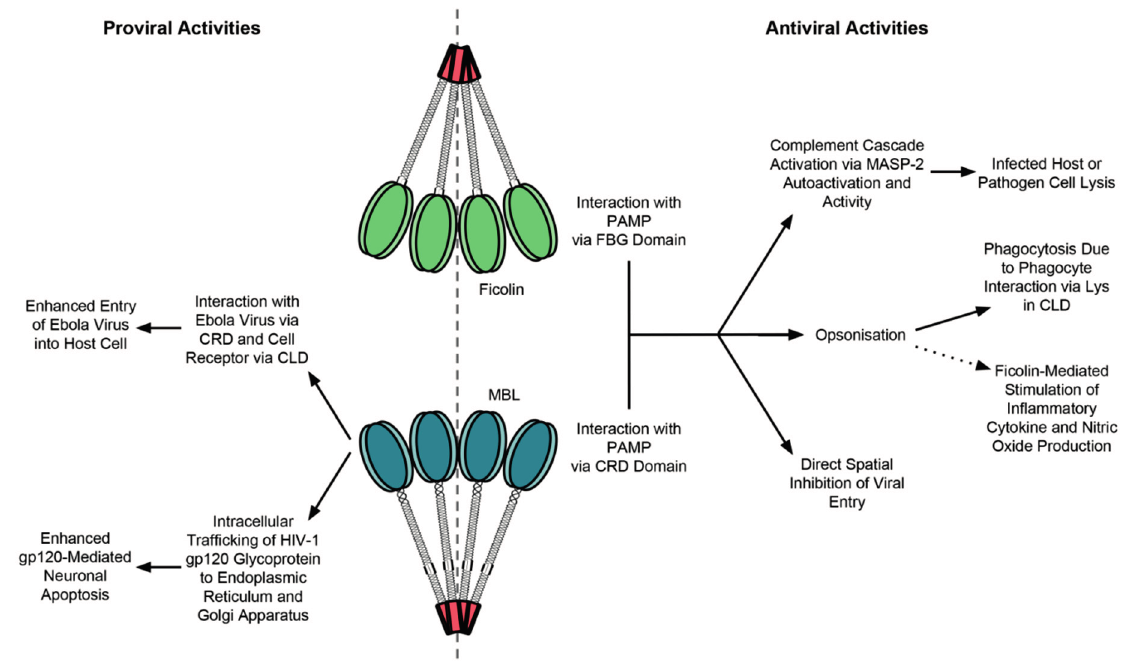
Figure 4. The pro-viral and antiviral activities of serum MBL and ficolins. Both have antiviral activities through complement activation, opsonophagocytosis and direct spatial blocking of virus-receptor interactions and entry. Ficolins also enhance production of inflammatory cytokines and nitric oxide. MBL has specific pro-viral activities in Ebola virus and HIV-1 infections, through enhanced virus entry and neuronal apoptosis